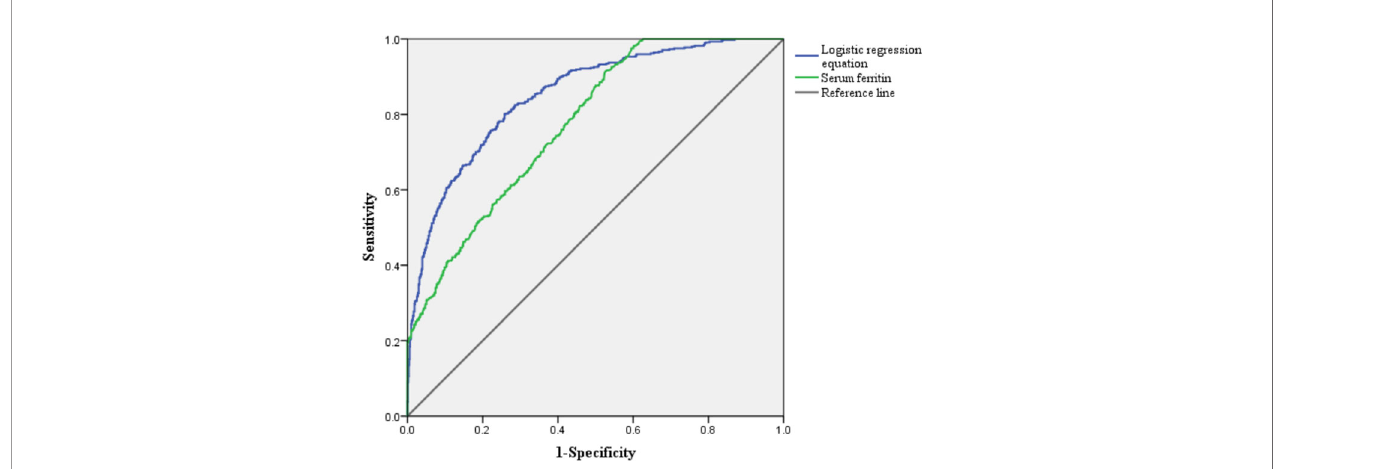
FIGURE 1 | Receiver operating characteristic curve for predicting acute kidney injury in critically ill patients with diabetes.